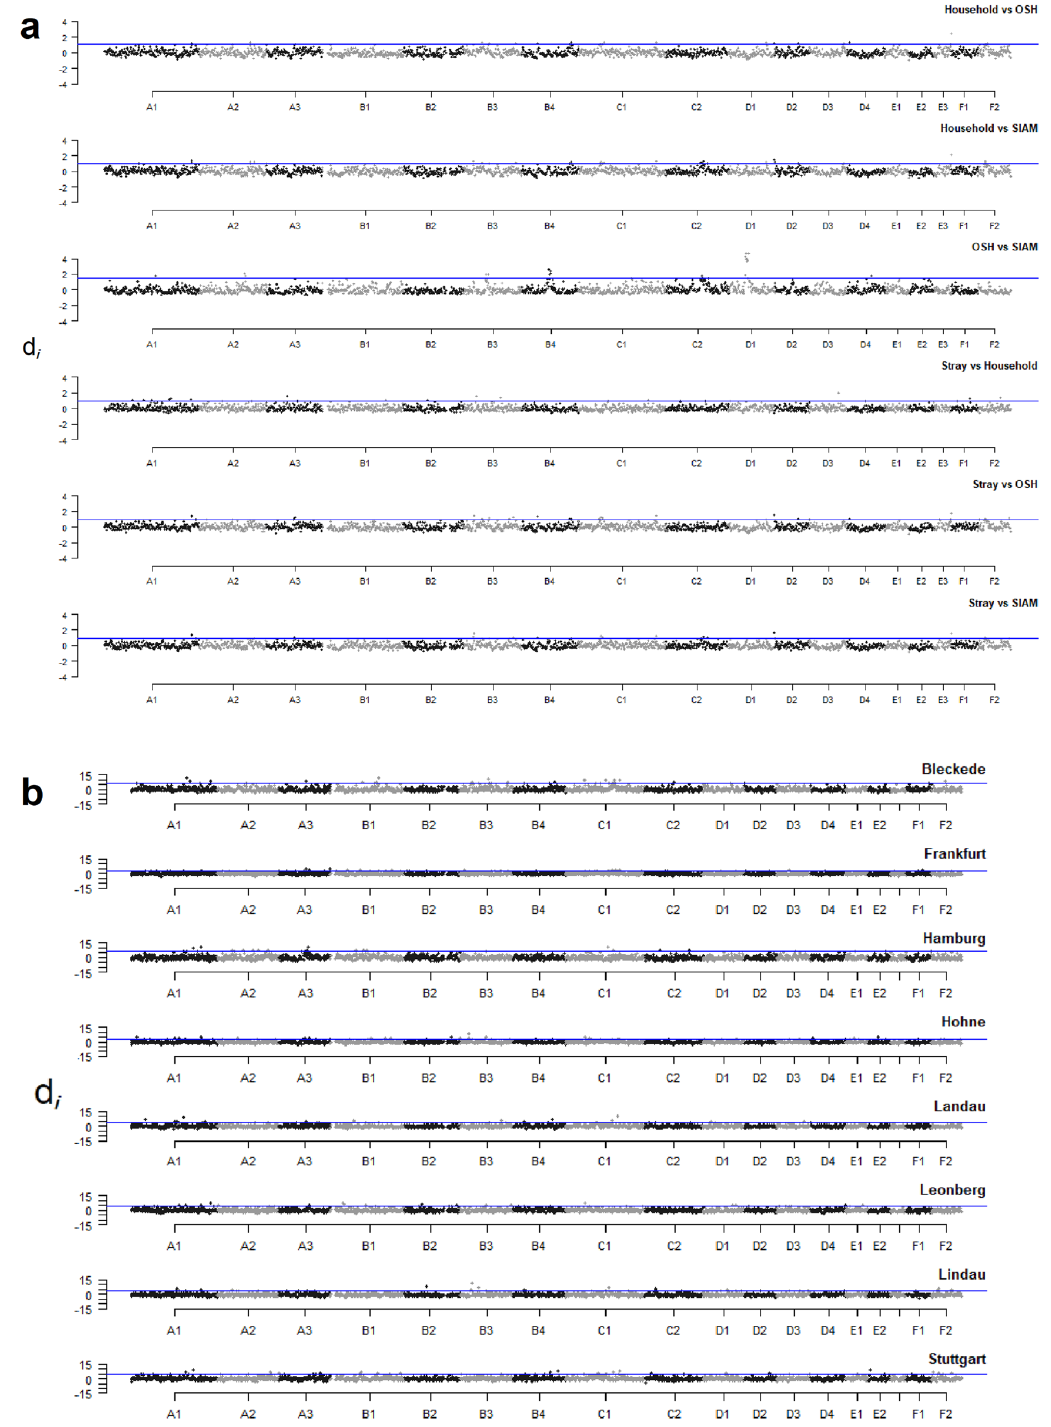
Figure 9. Distribution of the d i -summary statistics by cat populations and stray subpopulations. ( a ) The distributions of d i -summary statistics with stray compared to household, OSH and SIAM, respectively; household compared to stray, OSH and SIAM, respectively; OSH compared to stray, household, OSH and SIAM, are shown for each 1 Mb interval across all autosomes. ( b ) The distributions of d i -summary statistics with for each of the eight stray subpopulations compared to the other 7 stray subpopulations. Alternating grey and black indicate values in d i -summary statistics from neighboring chromosomes. The blue line indicates the 99th percentile for the